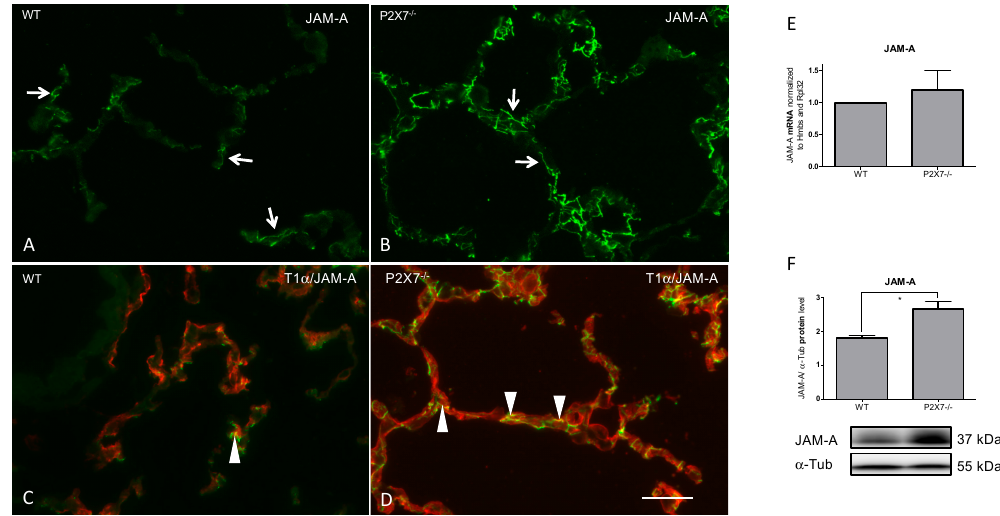
Figure 1. Frozen sections of mouse lung tissue. Immunofluorescence demonstration of JAM-A in WT and P2X7 − / − mice ( A – D ). Note the increase in immunoreactivity of JAM-A in P2X7 − / − mice ( B , D ). ( C , D ) Double immunofluorescence with the AECI marker T1 α (TexasRed). Arrows show the linear pattern of JAM-A. Arrowheads depict examples of epithelial junctions. Bar = 100 µ m. Corresponding mRNA ( E ) (Wildtype (WT) normalized to 1; n = 3; p -value 0.5737) and protein ( F ) ( n = 3, p -value 0.0357) levels in lung homogenates. * p < 0.05 .